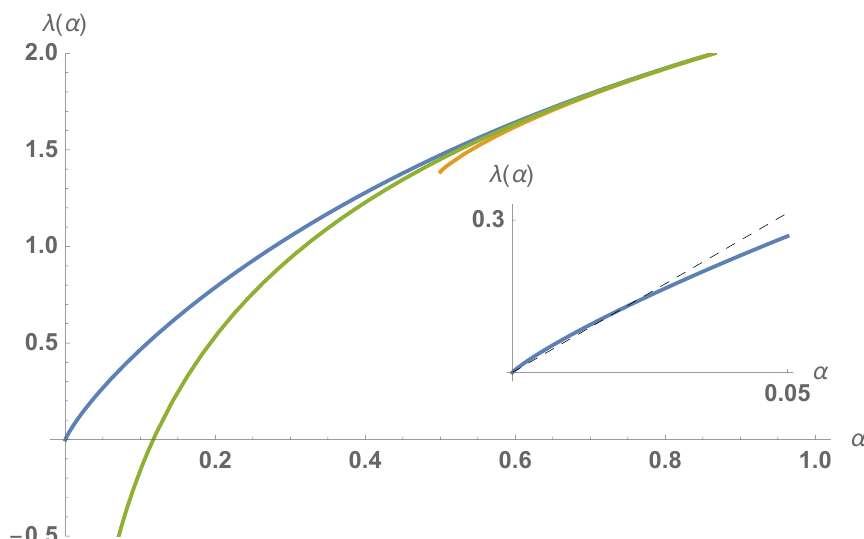
√ Figure 1 . Number of points of a cubic “lattice” of size 2 within a ball of radius 2 αc . Blue line: λ ( α, 0) . Orange line: λ ( α, 2) . Green line: ln( πeα ) . For α < p/ 4 , formally λ ( α, p ) = −∞ , which means no lattice vectors lie within the sphere of radius 2 αc < pc/ 2 . Inset: λ ( α, 0) , blue line, vs sparseness condition 2 πα , black dashed line, see section